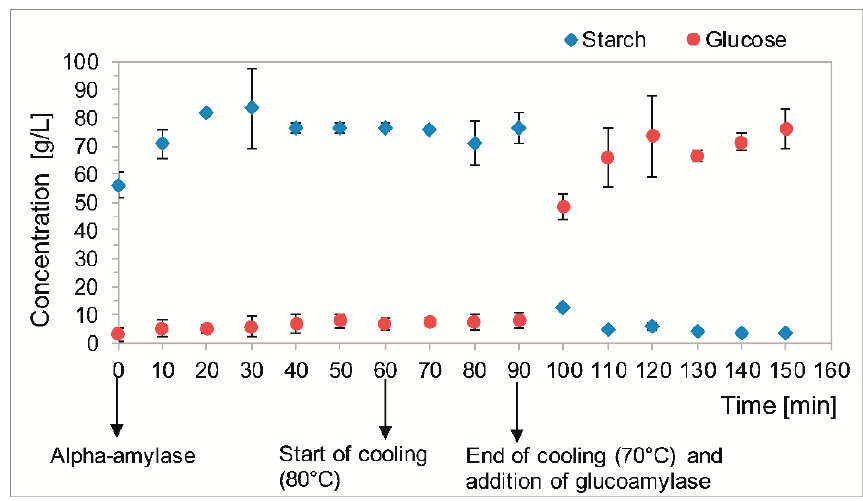
Figure 1. Evolution of starch and reducing sugar concentrations in mashing time n = 2.